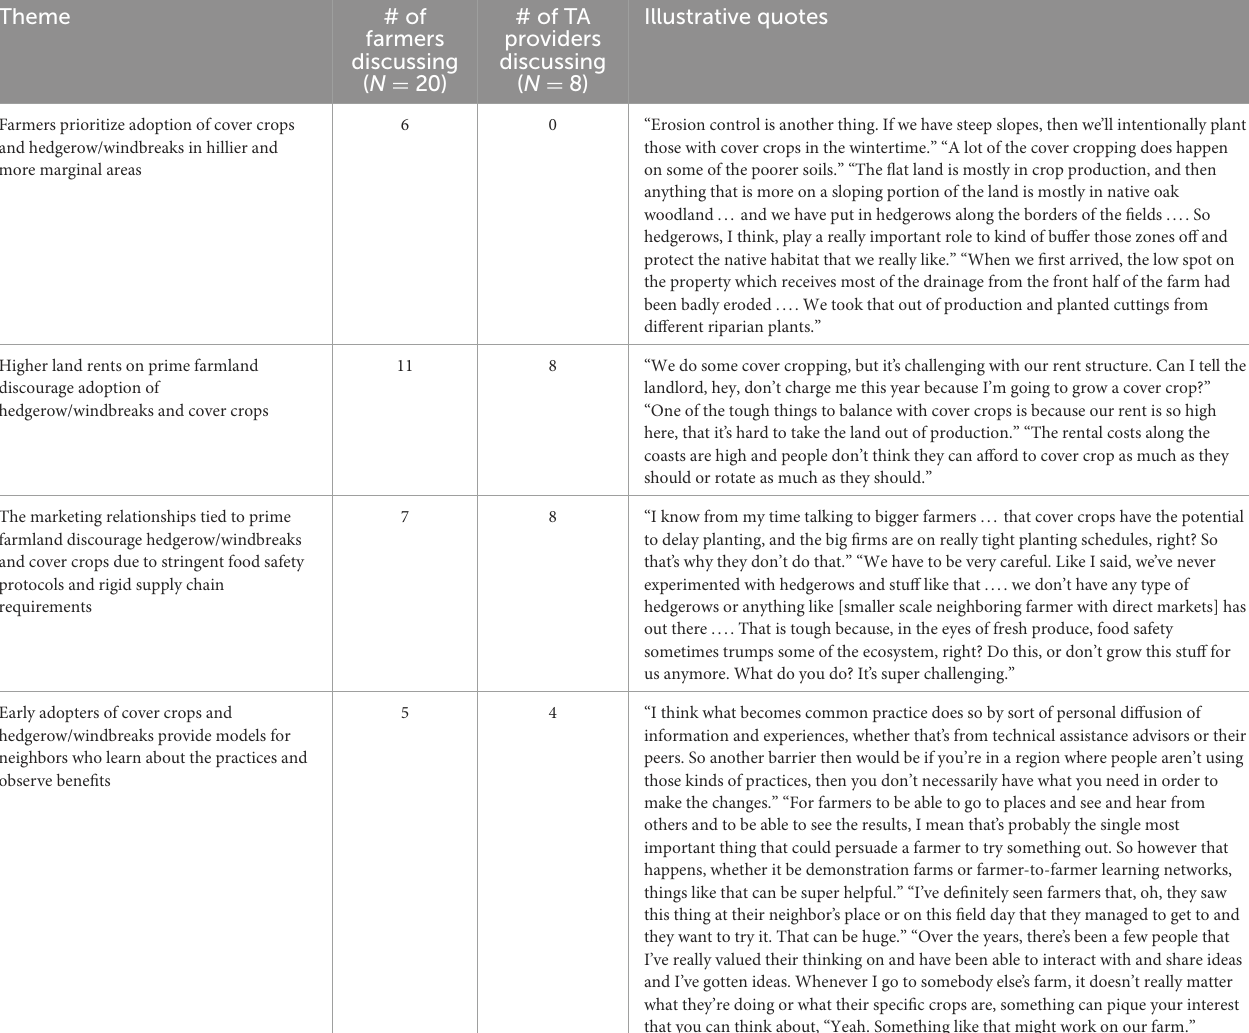
TABLE 4 Key themes and quotes helping to explain patterns of adoption of cover crops and hedgerow/windbreaks from interviews with 20 growers and 8 technical assistance providers in California’s Central Coast. Theme # of farmers